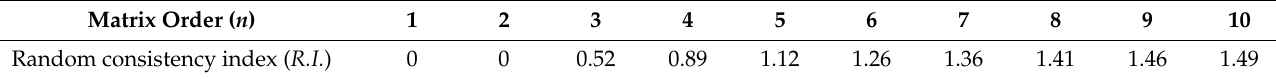
Table 2. Average random consistency